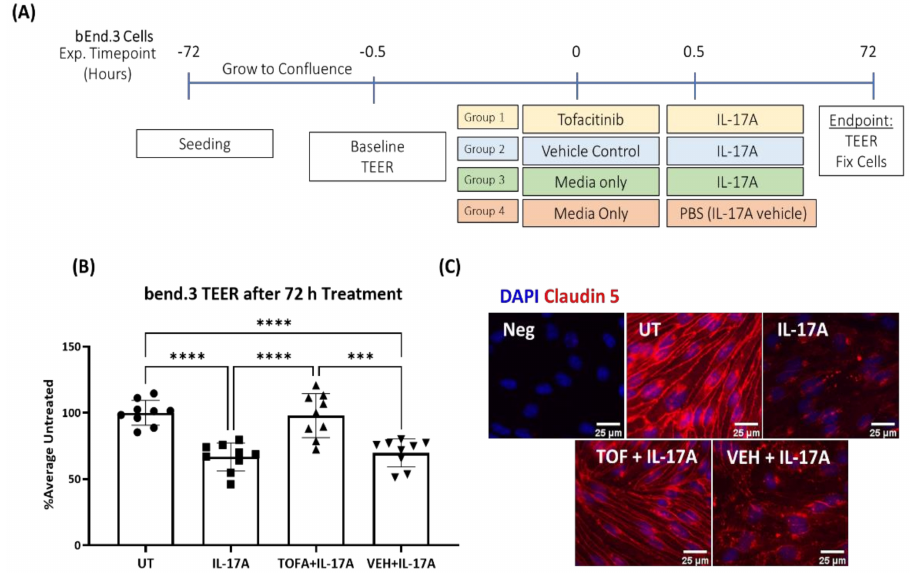
Figure 4. The effect of Tofacitinib Citrate on IL-17A-induced barrier dysfunction and claudin-5 junction dysmorphia in bEnd.3 cells. The bEnd.3 cells were pretreated with Tofacitinib Citrate (4.955 µ M) for 30 min, followed by IL-17A (100 ng/mL) incubation for 30 min. TEER and claudin-5 expression in bEnd.3 cells was examined 72 h later. ( A ) Scheme of experimental design. ( B ) TEER in bEnd.3 cells from different groups. UT, untreated; Mean ± SD; *** p < 0.001, **** p ≤ 0.0001 by One-Way ANOVA with Tukey’s multiple comparisons test. ( C ) Immunostaining for claudin-5 (red), DAPI (blue). Scale bar = 25 µ m.